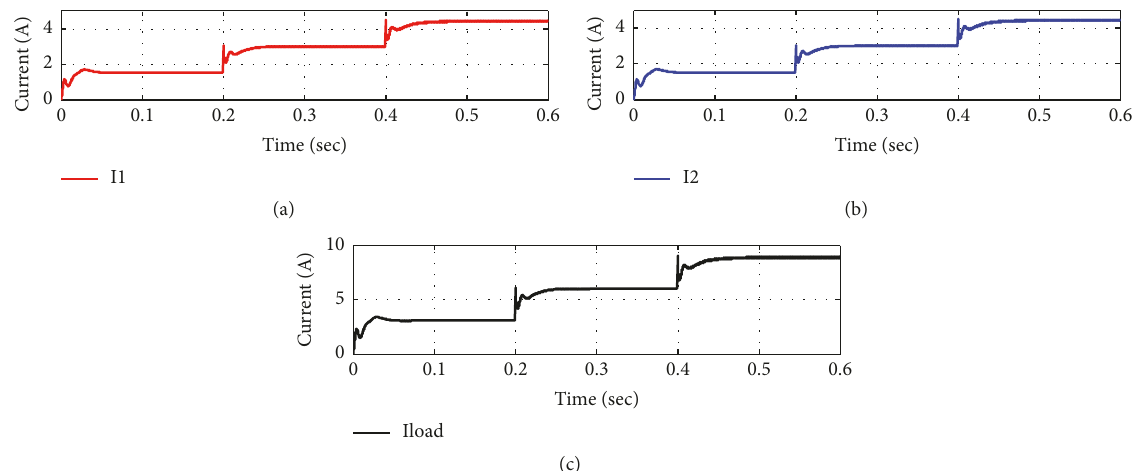
Figure 14: The output current from the simulation results of no mismatch case: (a) converter I output current; (b) converter II output current; (c) load